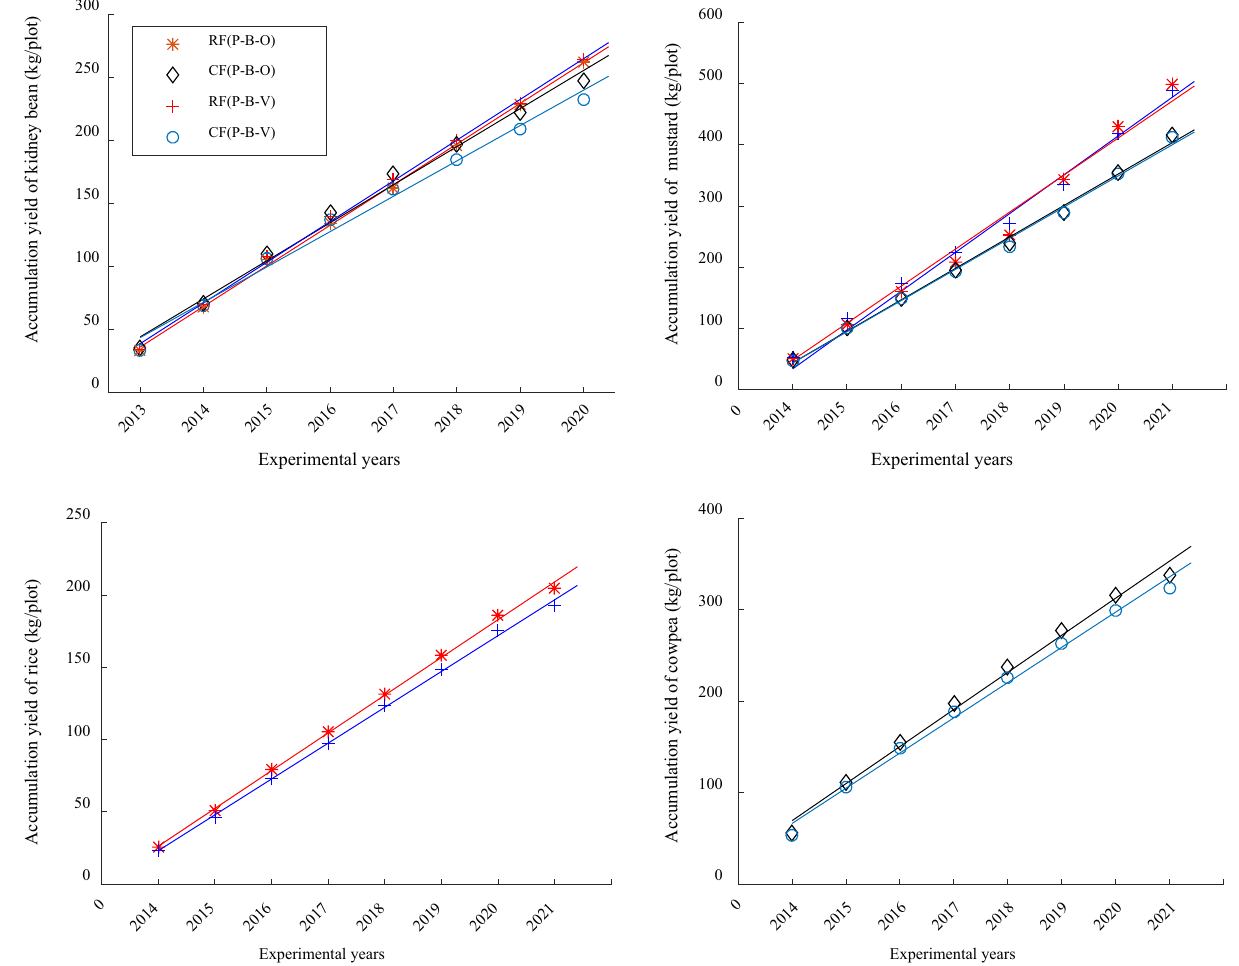
Figure 2. Change trends of annual cumulative yields of crops for different treatments.